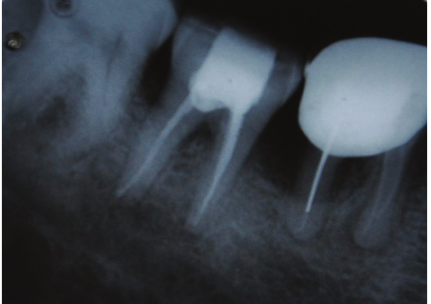
Figure 5: Obturation.